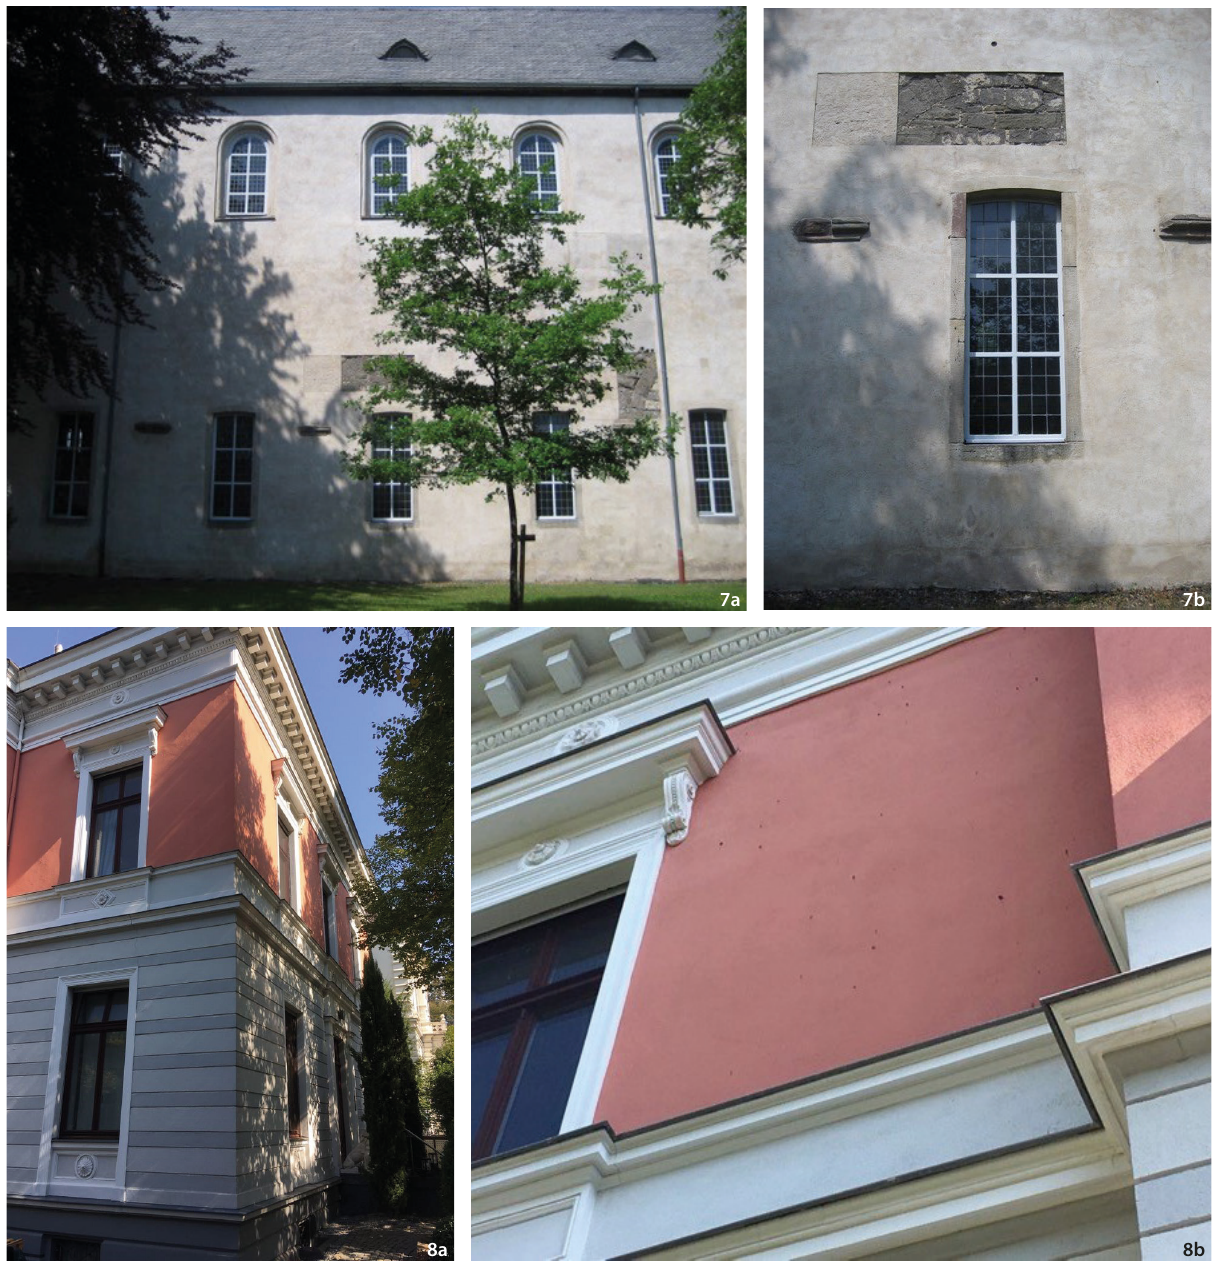
Figure 7a South façade, one decade after the application of the sacrificial lime mortar based on natural hydraulic lime (Source: the author). Figure 7b The ‘window to history’ (Source: the author). Figure 8 Pictures of Classicist Villa, Park Street, Wiesbaden, Germany, in 2018; 20 years after restoration with lime plaster and red-coloured lime paints (Source: the